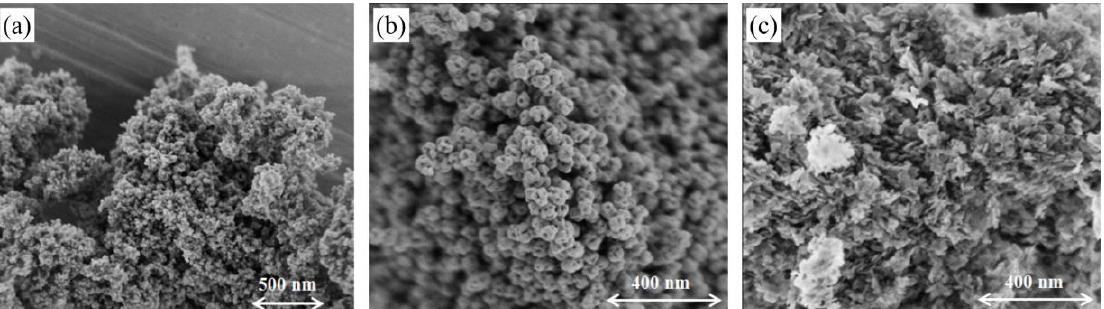
Figure 2. SEM images of nanoparticles: ( a ) SiO 2 ; ( b ) TiO 2 ; ( c ) Al 2 O 3 .